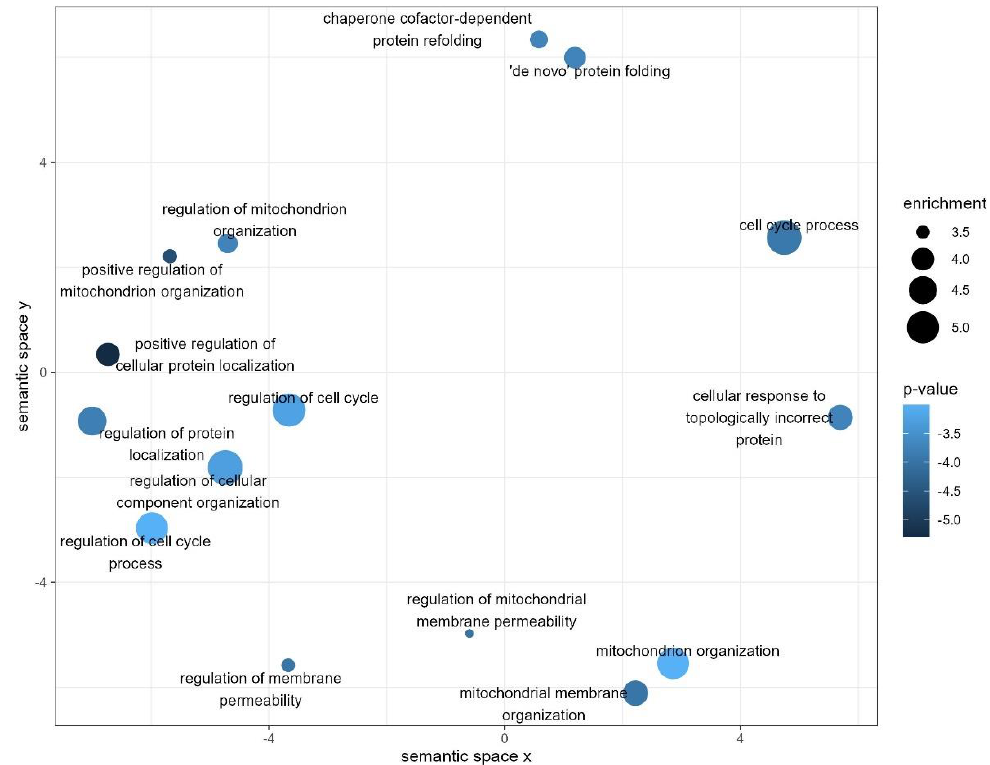
Figure 3. Distribution and the prevalence of GO biological process terms (filtered at p < 0.001) associated with the set of significantly different proteins. The semantic analysis is based on Resnik’s algorithm and measures the similarity between the enriched ontology terms after the elimination of redundant terms. The defined enrichment measure (circle size) defines relative abundance and the direction of a certain biological process within the study group (CRVO) relative to the control groups. The majority of processes attributed to cell cycle or mitochondria organization are significantly depleted or abolished, while the regulation of improperly folded proteins and stress response reaction are organized in the enhanced acting cluster.